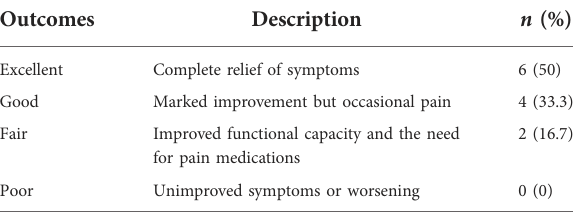
TABLE 3 Modi fi ed MacNab outcomes of 12 months after operation or at last follow-up ( n